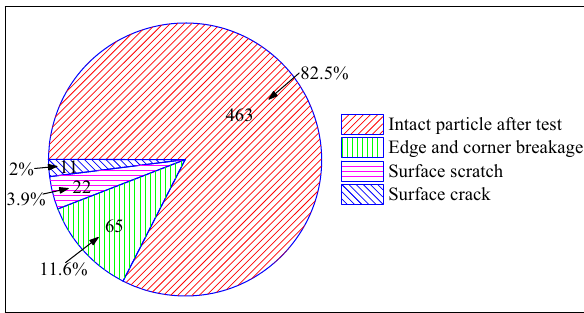
Fig. 23 Pie chart of the ballast granule degradation after 4 million cycles of